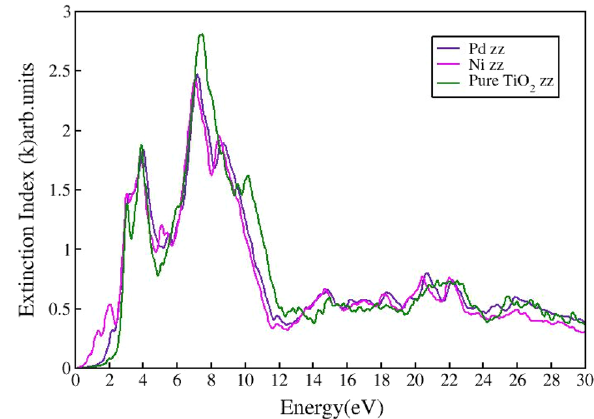
Fig. 3 Absorption spectra of TiO 2 doped with 1Pd/1Ni and Pure TiO 2